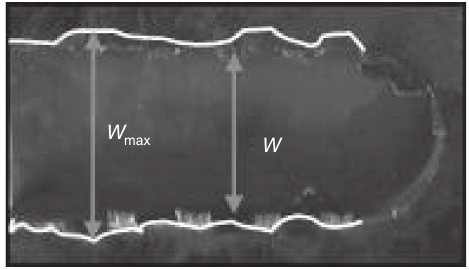
Figure 2 A photograph of measurement of damage width.